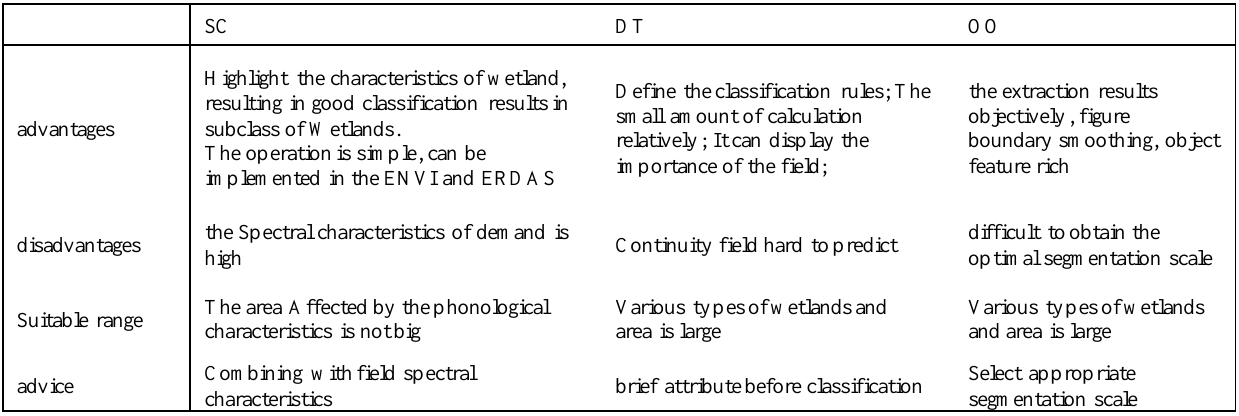
Table10. Comparison of SC, DC and